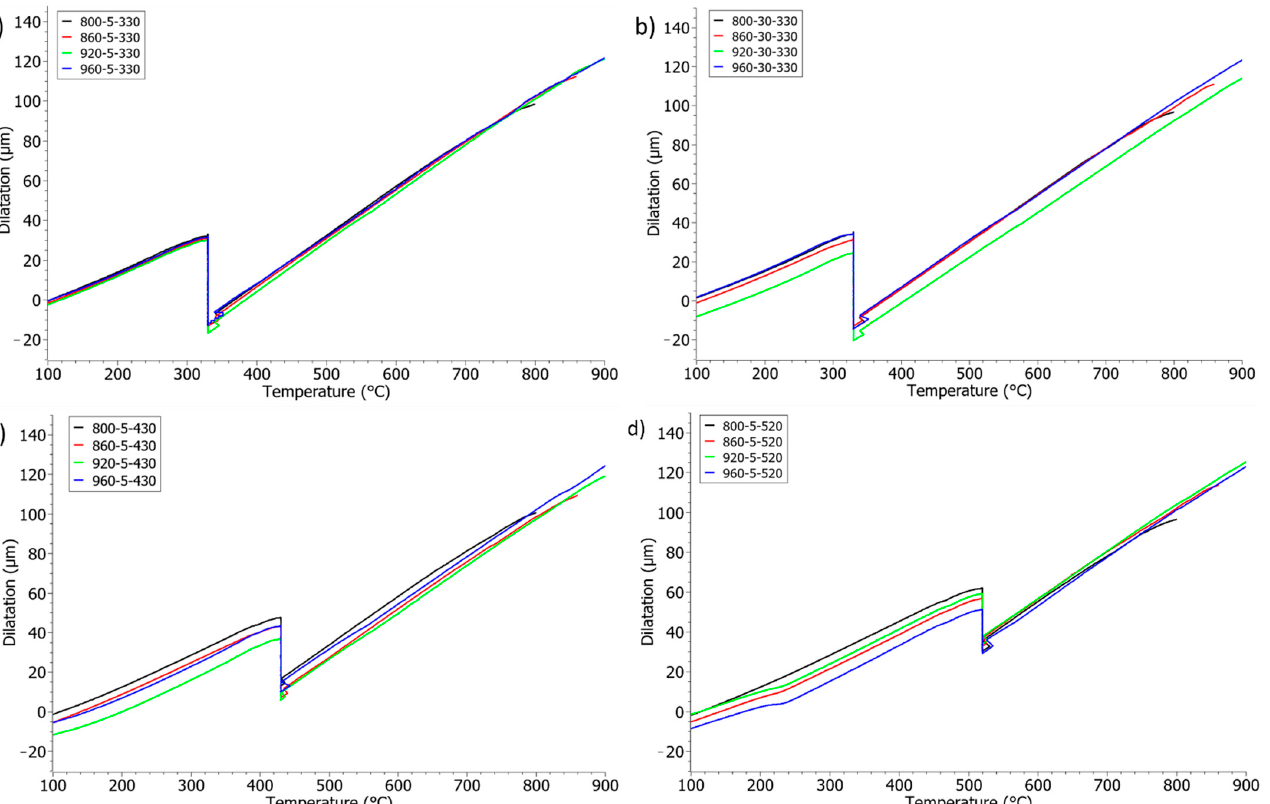
Figure 5. Dilatometric cooling curves of the samples at isothermal bainite transformation, ( a ) 5 min at austenitisation temperature, at 330 °C isothermal bainitic temperature, ( b ) 30 min at austenitisation temperature, at 330 °C isothermal bainitic temperature, ( c ) 5 min at austenitisation temperature, at 430 °C isothermal bainitic temperature and ( d ) 5 min at austenitisation temperature, at 520 °C isothermal bainitic temperature.